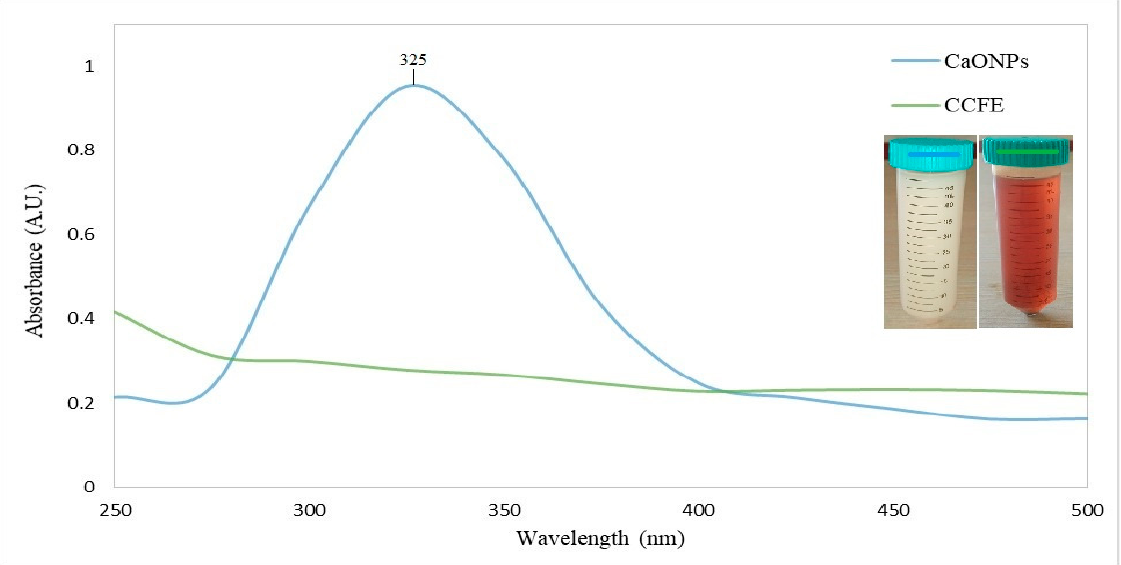
Figure 1. The UV-Vis spectrograph of calcium oxide nanoparticles. CaONPs—calcium oxide nanoparticles; CCFE— C. colocynthis fruit extracts.